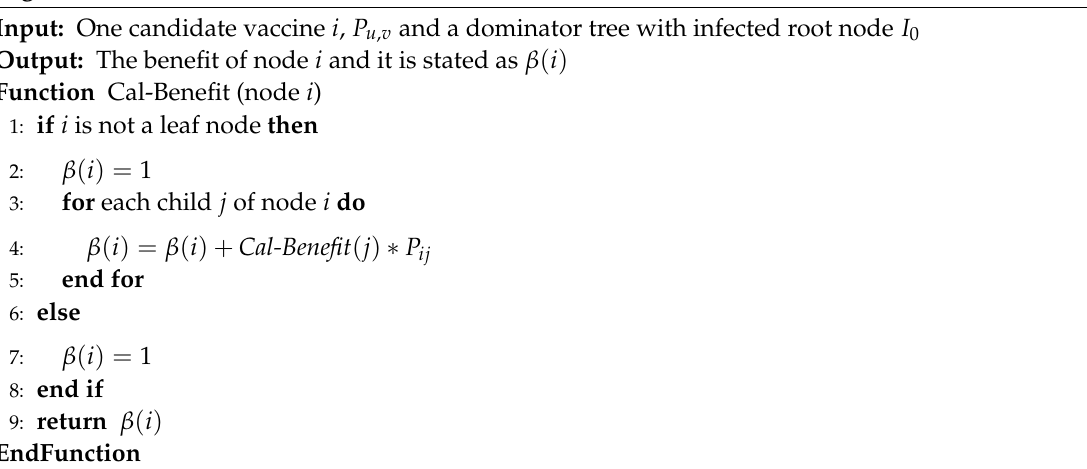
Algorithm 1 Benefit of one candidate